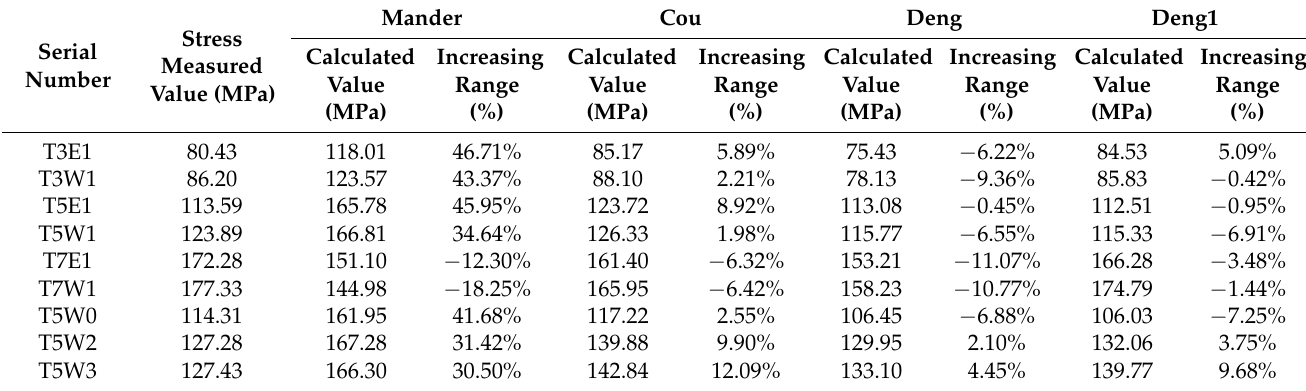
Table 6. Model calculation results and